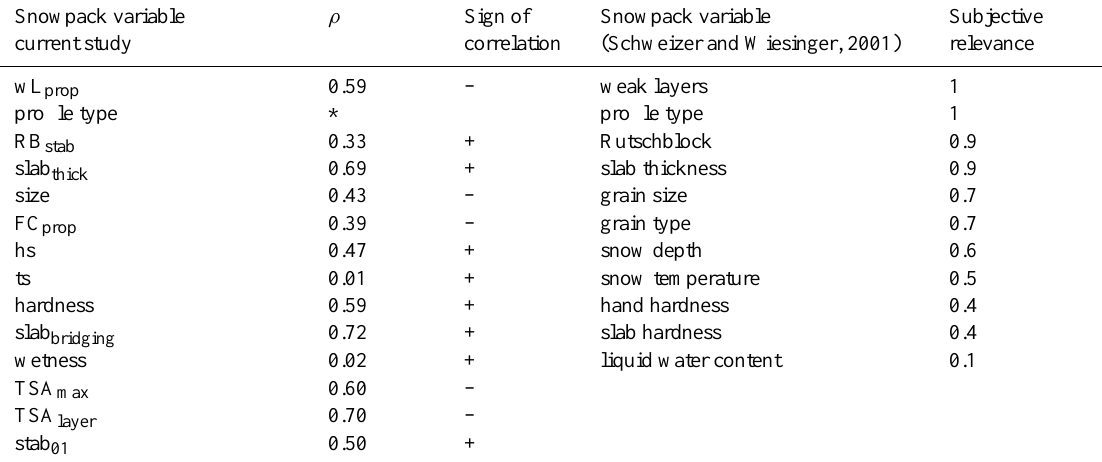
Table 4. Relevance/contribution of snow stability and snowpack structure observations for stability assessment according to Schweizer and Wiesinger (2001, stab 01 , right part of table). Parameters were subjectively ranked by nine experienced forecasters (score between 0 – not important and 1 – very important). The left part of the table shows the approximately corresponding parameters for the presented study. For these variables, the Spearman correlation ρ to the manually classified snowpack structure (SNPK manual ) is given. The correlation is not for all investigated parameters shown. * Profile type (nominal variable) – no correlation